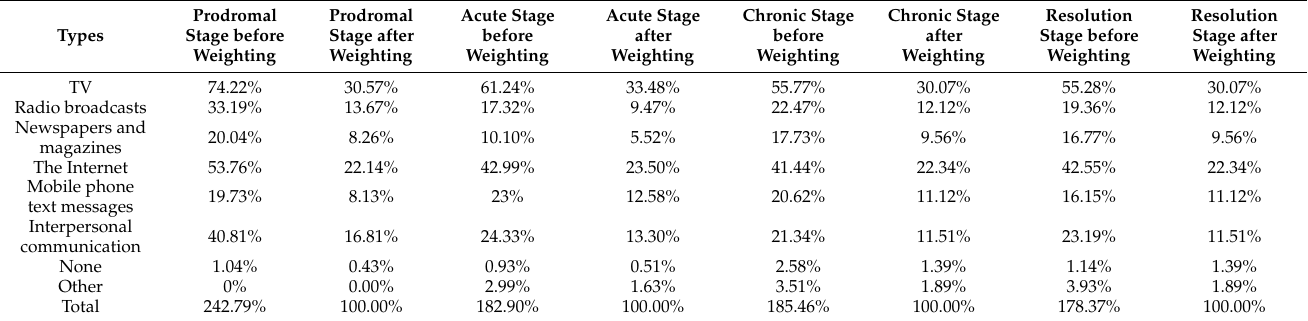
Table 8. Information communication channel preferences in the different stages of an earthquake